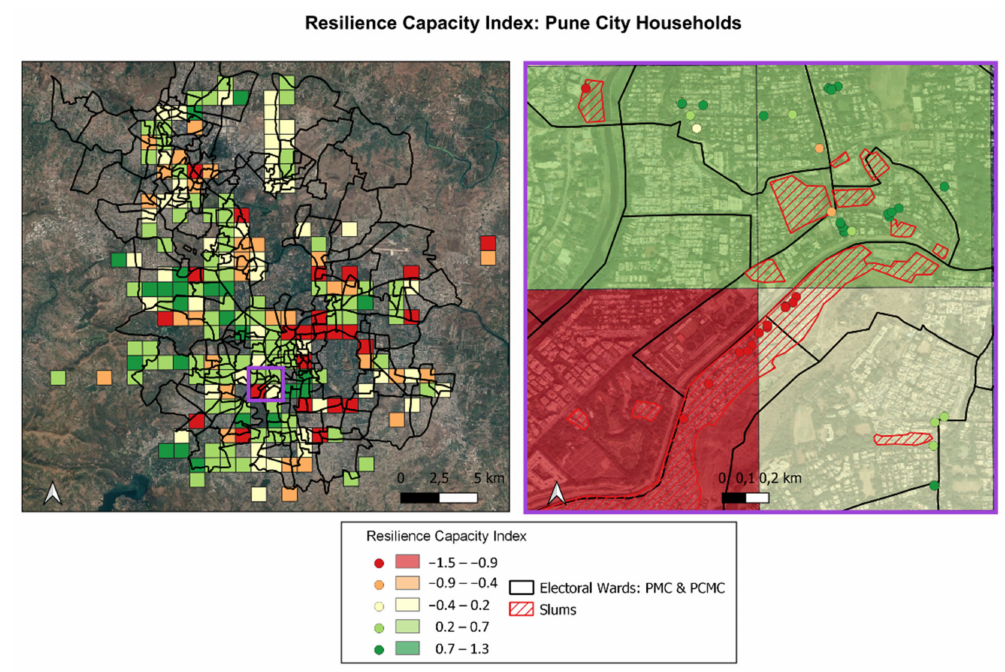
Figure 4. Resilience capacity index of Pune households using 1000 m grids. In the zoomed-in section (purple), slums are shown hatched in red. Dots correspond to individual households. For data security reasons, locations correspond to the next street crossing, not the exact